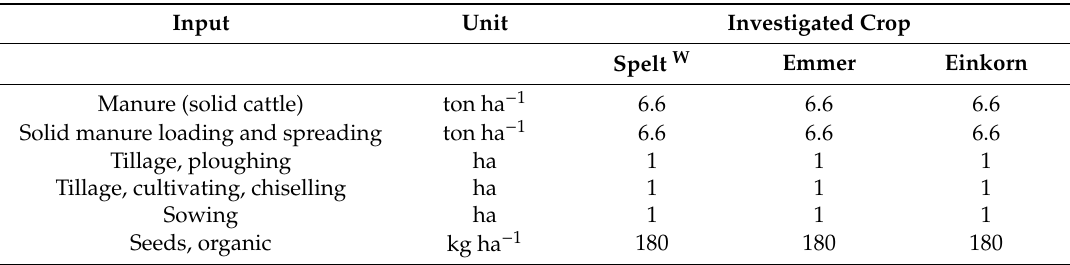
Table 1. Input data